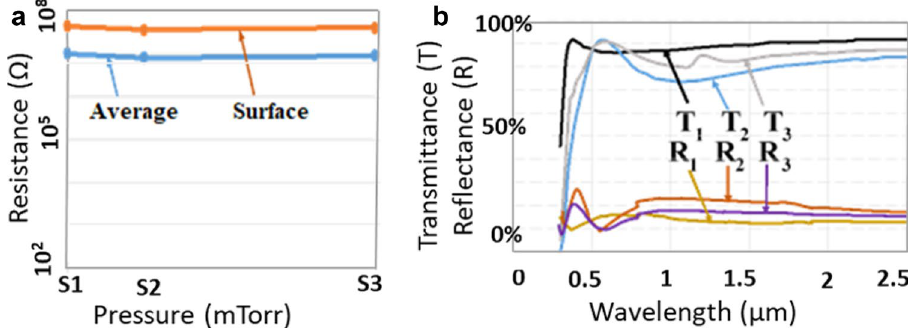
Fig. 5 a Average and surface electrical resistance at different pressure (10, 7, 5 mTorr for the individual samples), and b transmittance (T) and reflec- tance (R) of the films at differ- ent